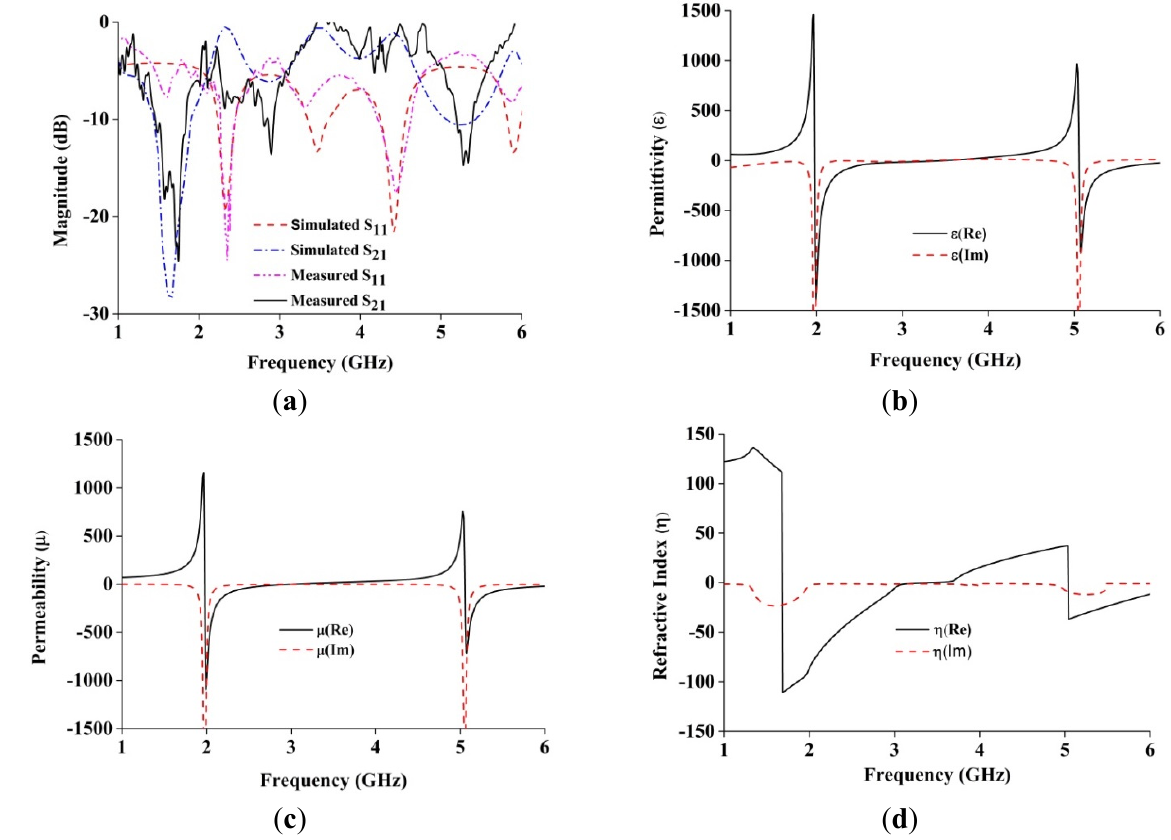
Figure 3. ( a ) Spectral response of the metamaterial structure; ( b ) Real and imaginary values of effective permittivity ( ε ) vs. frequency; ( c ) Real and imaginary values of effective permeability (µ) vs. frequency; ( d ) Real and imaginary values of refractive index ( η ) vs.